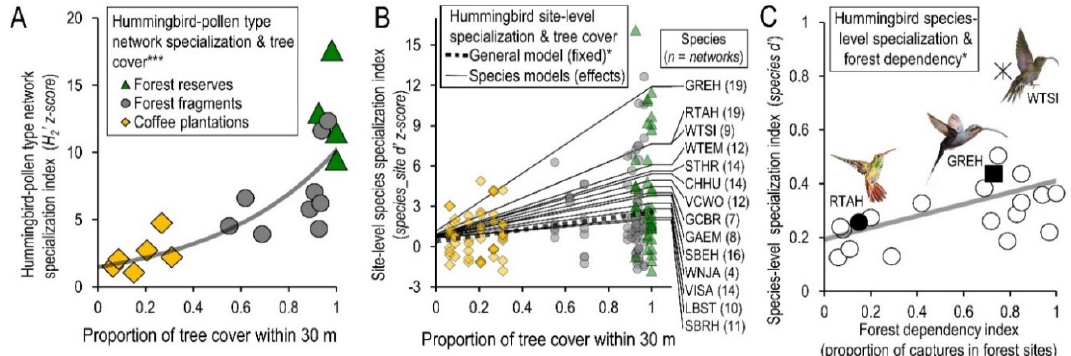
Figure 4. Hummingbird–pollen type network specialization ( H 2 ′ z-score ) eroded with the loss of tree cover within 30 m of mist nets at each site ( A ). A generalized linear mixed effect model (GLMM) based on the proportion of tree cover within 30 m of mist nets at each site suggested that hummingbirds are less specific in their interactions and relax their specificity when they live and/or forage in coffee plantations, especially P. guy ( B ). Species-level specialization values based on pooling all sites into a single large network ( species d’ ) were significantly correlated with forest dependency index for 20 species. A. tzacatl (RTAH), P. guy (GREH), and E. aquila (WTSI) are labeled with symbols and images from Figure 4. Open circles in the plot represent 17 other hummingbird species with sufficient data to calculate species specialization ( C ).